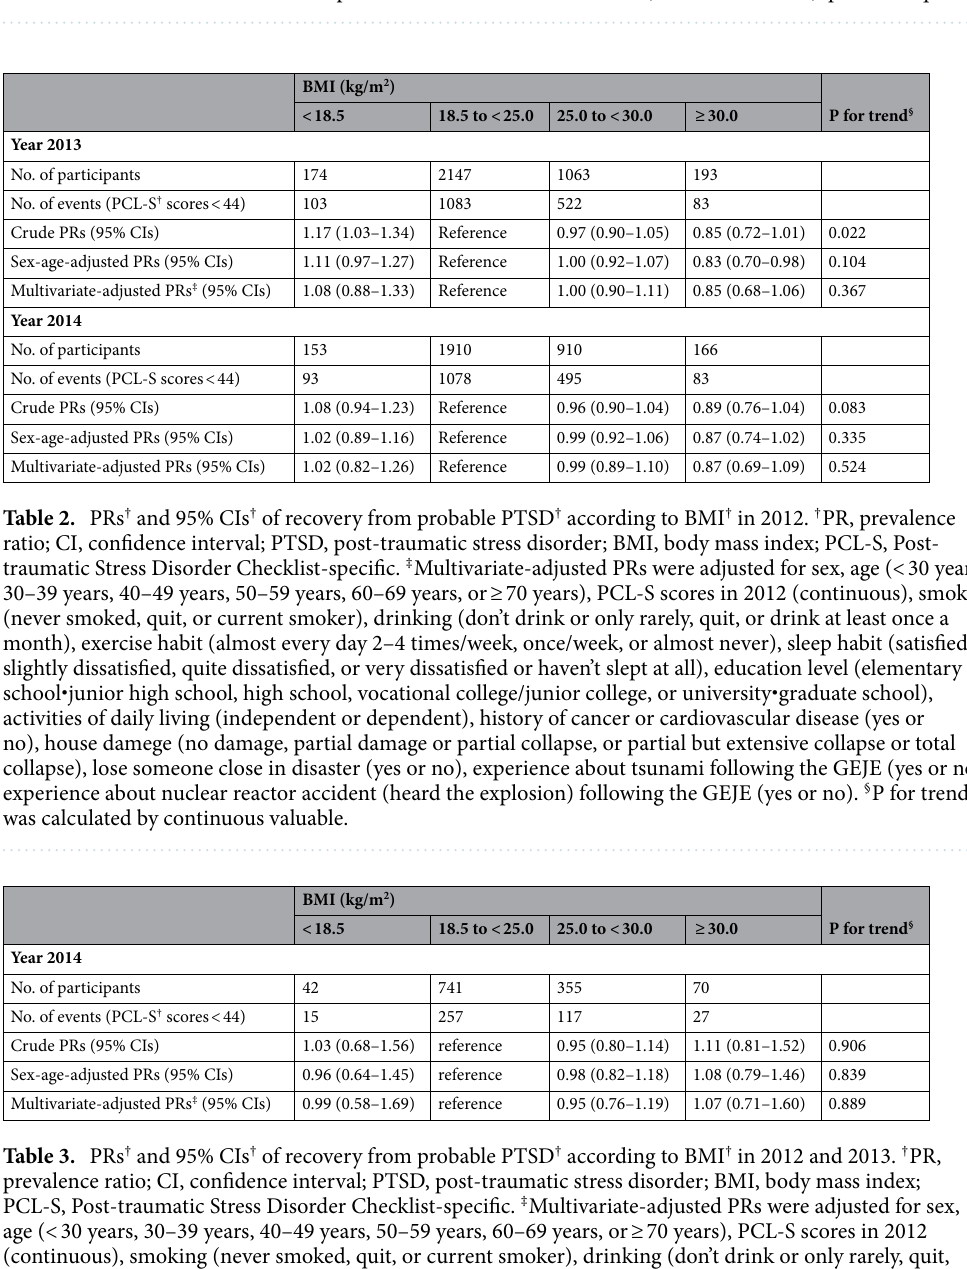
Table 1. Baseline characteristics by BMI † in 2012, Fukushima, Japan. † BMI, body mass index; PCL-S, Post- traumatic Stress Disorder Checklist-specific, SD; standard deviation, GEJE; the Great East Japan Earthquake.